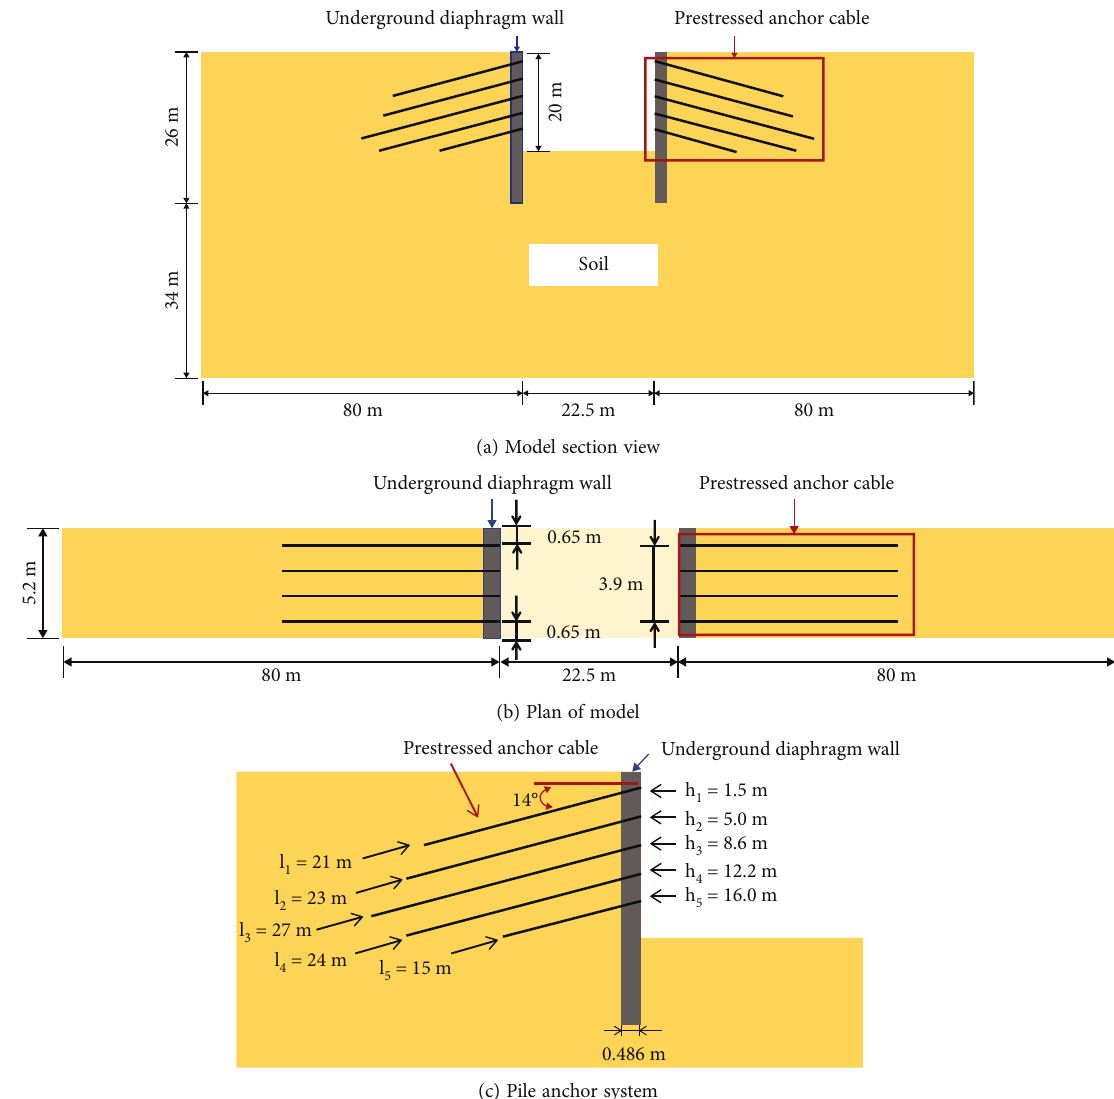
Figure 3: Simpli fi ed schematic of the 3D numerical model.